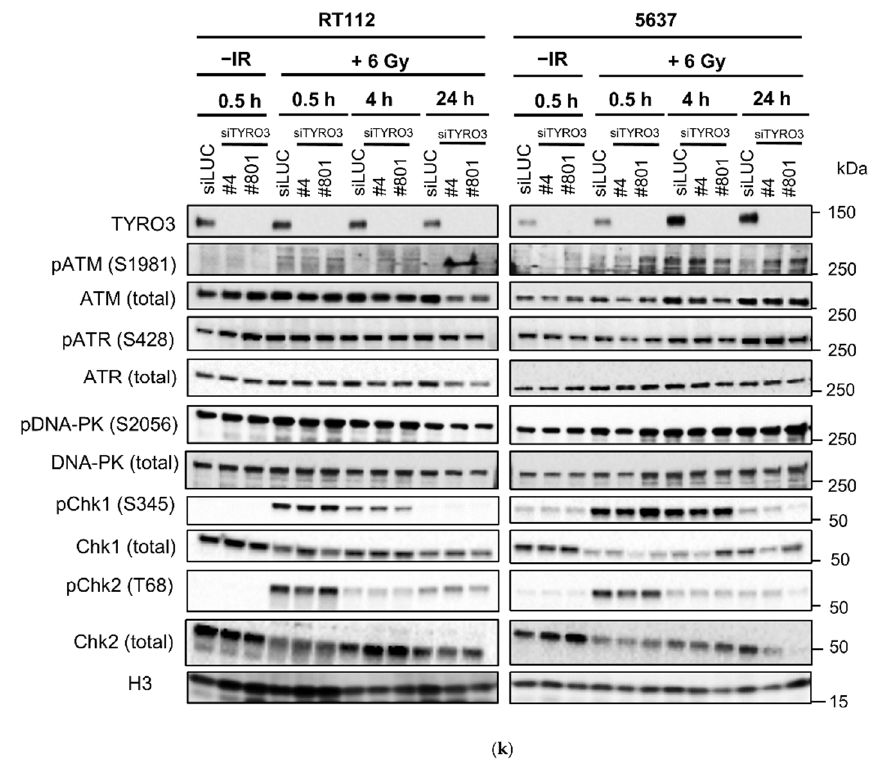
Figure 2. TYRO3 modulation and its impact on Ionizing Radiation-Induced Foci and DNA damage. γ H2AX foci visualized after 24 h of 2 Gy irradiation in TYRO3 downregulated RT112 ( a ) or 5637 ( c ) cells (scale bar 5 microns); Quantification of cells containing more than 10 γ H2AX foci at 24 h after 2 Gy of irradiation in the downregulated RT112 ( b ) and 5637 ( d ) cell lines; ( e ) γ H2AX foci visualized after 24 h of 2 Gy irradiation in TYRO3 overexpressing UM-UC-3 cell line (Scale bar 5 microns); ( f ) Quantification of cells containing more than 10 γ H2AX foci at 30 min and 24 h after 2 Gy of irradiation in TYRO3 overexpressing cell lines. The data shown above is from three different experiments and error bars represent the SD. Unpaired t -test analysis: * p < 0.05; ** p < 0.005; *** p < 0.0005; **** p < 0.0005, ns: non-significant. Representative images of the alkaline Comet assay performed on TYRO3 downregulated RT112 ( g ) and 5637 ( h ) cells and the resulting Olive tail moments analysis in TYRO3 downregulated RT112 ( i ) and 5637 ( j ) cells irradiated at 6 Gy. The data shown here is from three independent experiments analyzing 200 nucleus per condition per experiment, horizontal bars represent the median values. Kruskal-Wallis nonparametric tests with Multiple comparisons were used: * p < 0.05; ** p < 0.005, ns: non-significant; ( k ) western blot of DNA damage repair proteins; TYRO3 was downregulated, irradiated at 6 Gy and the lysates were prepared and analyzed 0.5–24 h after.